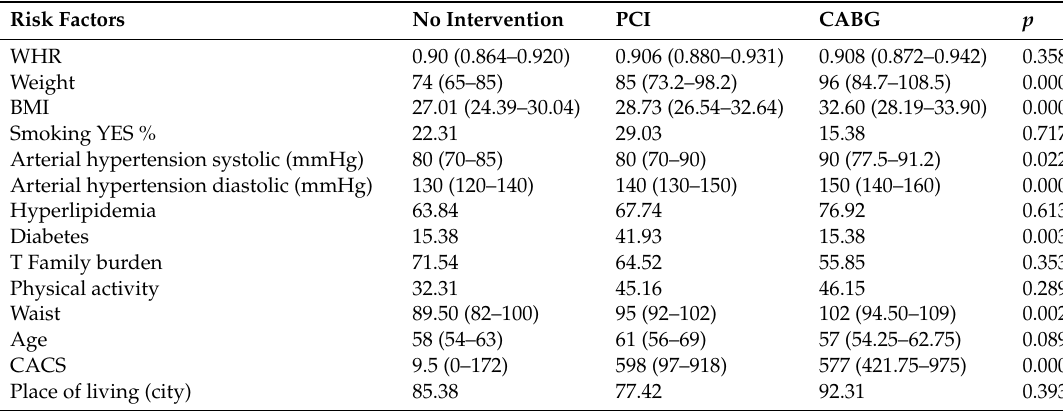
Table 1. Characteristics of the patients included in the